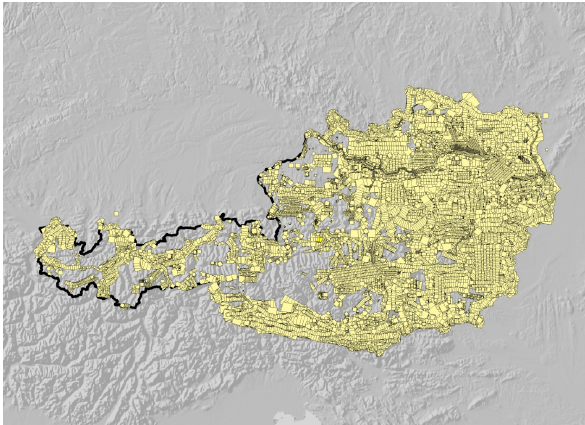
Figure 1: Map of the approximately determined footprints of more than 110,000 APs stored at the aerial archive of the De- partment for Prehistoric and Medieval Archaeology in